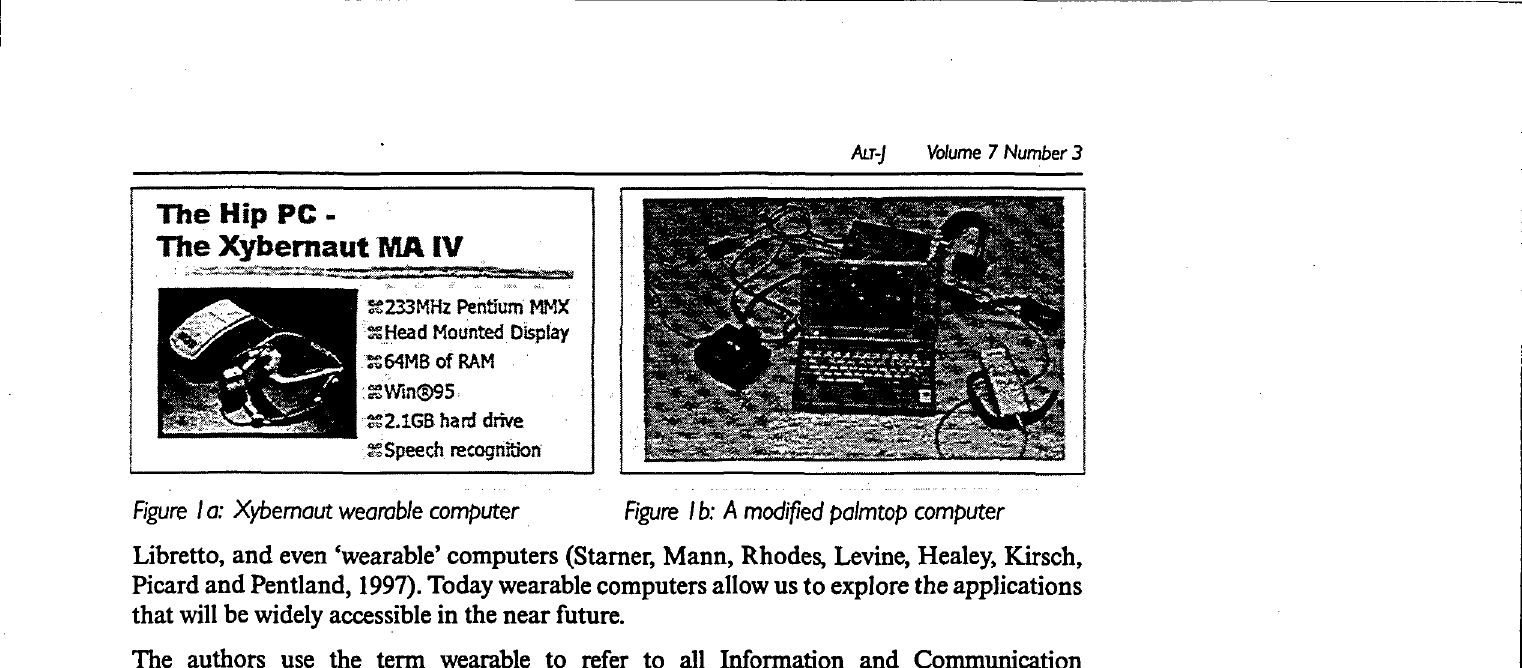
Figure / a: Xybernaut wearable computer Figure Ib: A modified palmtop